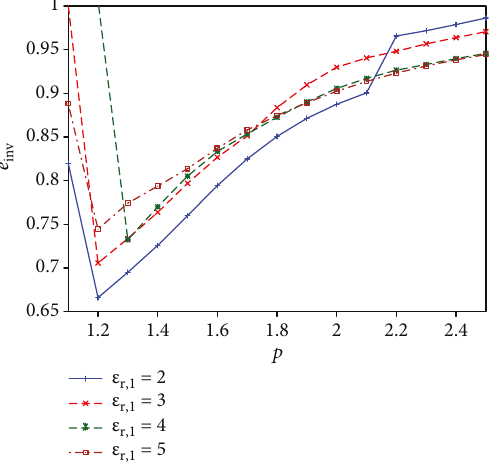
Figure 9: Behaviour of e values of the relative dielectric permittivity ϵ and cylinder.